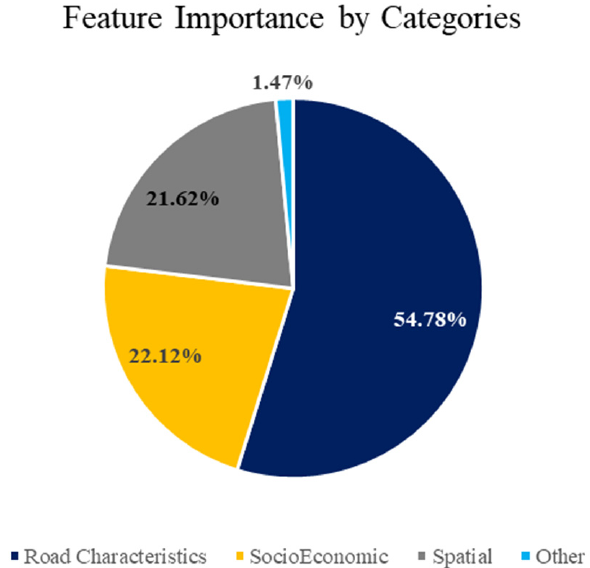
Figure 18. Categorical feature importance for the best-performing models (with spatial variables) for PVs.